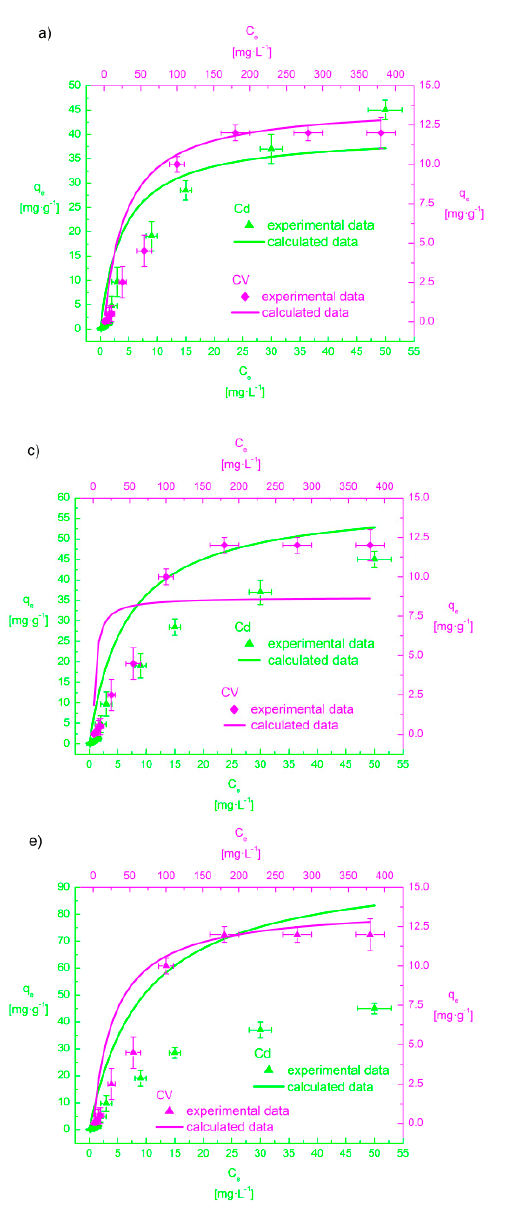
Figure 9. Estimation of Cr(III)–CV and Cd(II)–CV adsorption using ( a ) extended Langmuir model (EL) in the Cd(II)–CV system, ( b ) extended Langmuir model (EL) in the Cr(III)–CV system, ( c ) extended Langmuir–Freundlich (ELF) in the Cd(II)–CV system, ( d ) extended Langmuir–Freundlich (ELF) in the Cr(III)–CV system, ( e ) Jain–Snoeyink (JS) isotherm models in the Cd(II)–CV system, ( f ) Jain–Snoeyink (JS) isotherm models in the Cr(III)–CV system.